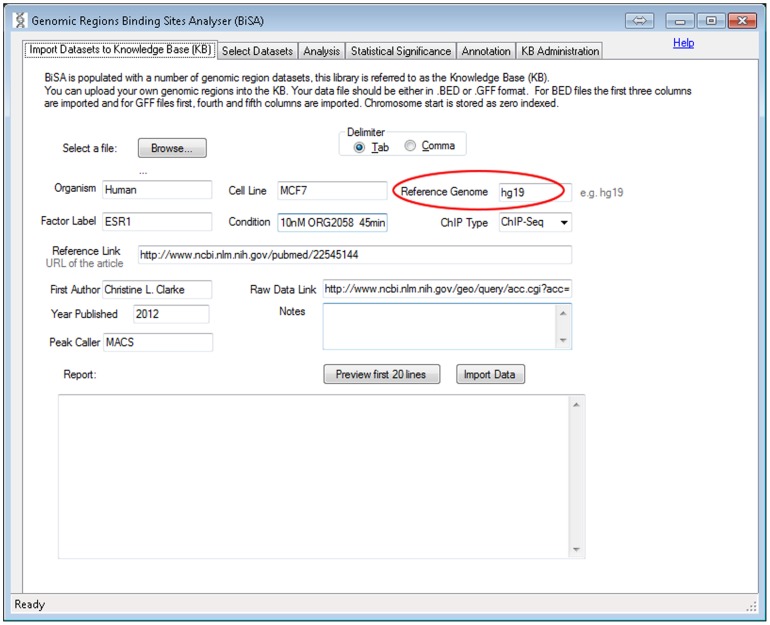
Import Datasets to Knowledge Base (KB).This step is optional and users can study data already saved in the KB, without importing datasets. In this step, the user can upload their own transcription factor DNA binding sites or histone modification locations, usually as BED or GFF peak files. If the file extension is other than BED or GFF, BiSA prompts the user to choose the right format. It is important to specify a Reference Genome (encircled), for instance hg18/hg19 for human or mm9/mm8 for mouse. BiSA will only allow comparisons between datasets of the same reference genome.